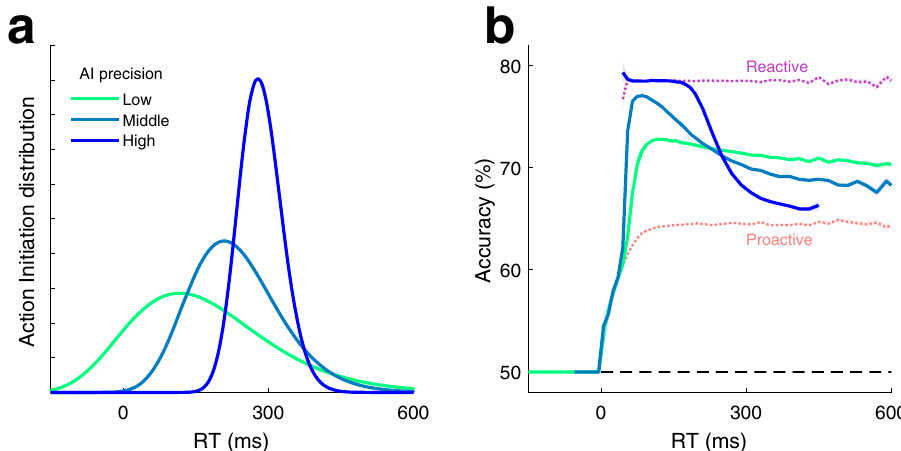
Fig. 8 Modulation of accuracy with manipulations of AI. a Distribution of proactive alone RTs for three simulated manipulations varying the latency and the degree of temporal precision of the AI. b Simulated tachometric curves obtained from the PSIAM using the AI processes shown in panel a and stimuli of intermediate strength ( s = 0.5). Contaminant responses were not incorporated into the model. We also simulated tachometric curves for the proactive (pink) and reactive (purple) responses; these two tachometric curves are independent of AI manipulations, and provide lower and upper bounds on accuracy, respectively. Source data are provided as a Source data fi